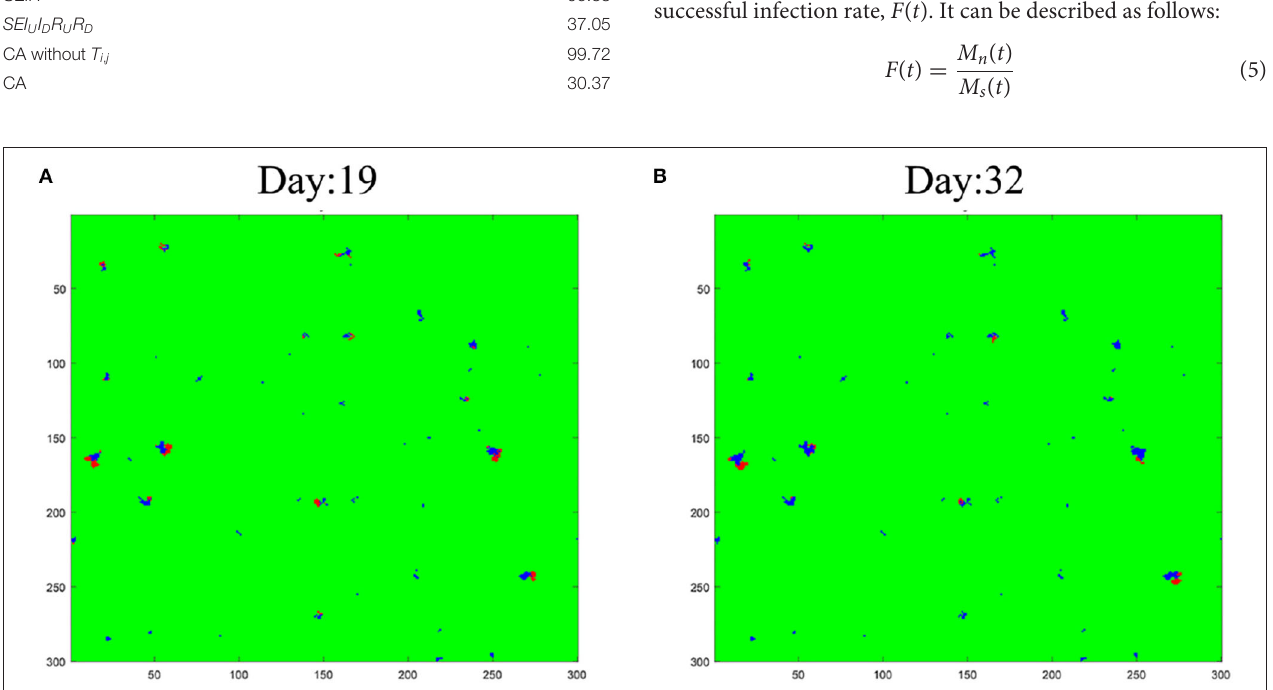
FIGURE 7 | Simulation results of CA: (A) is the results of 19th day; (B) is the results of 32th day.